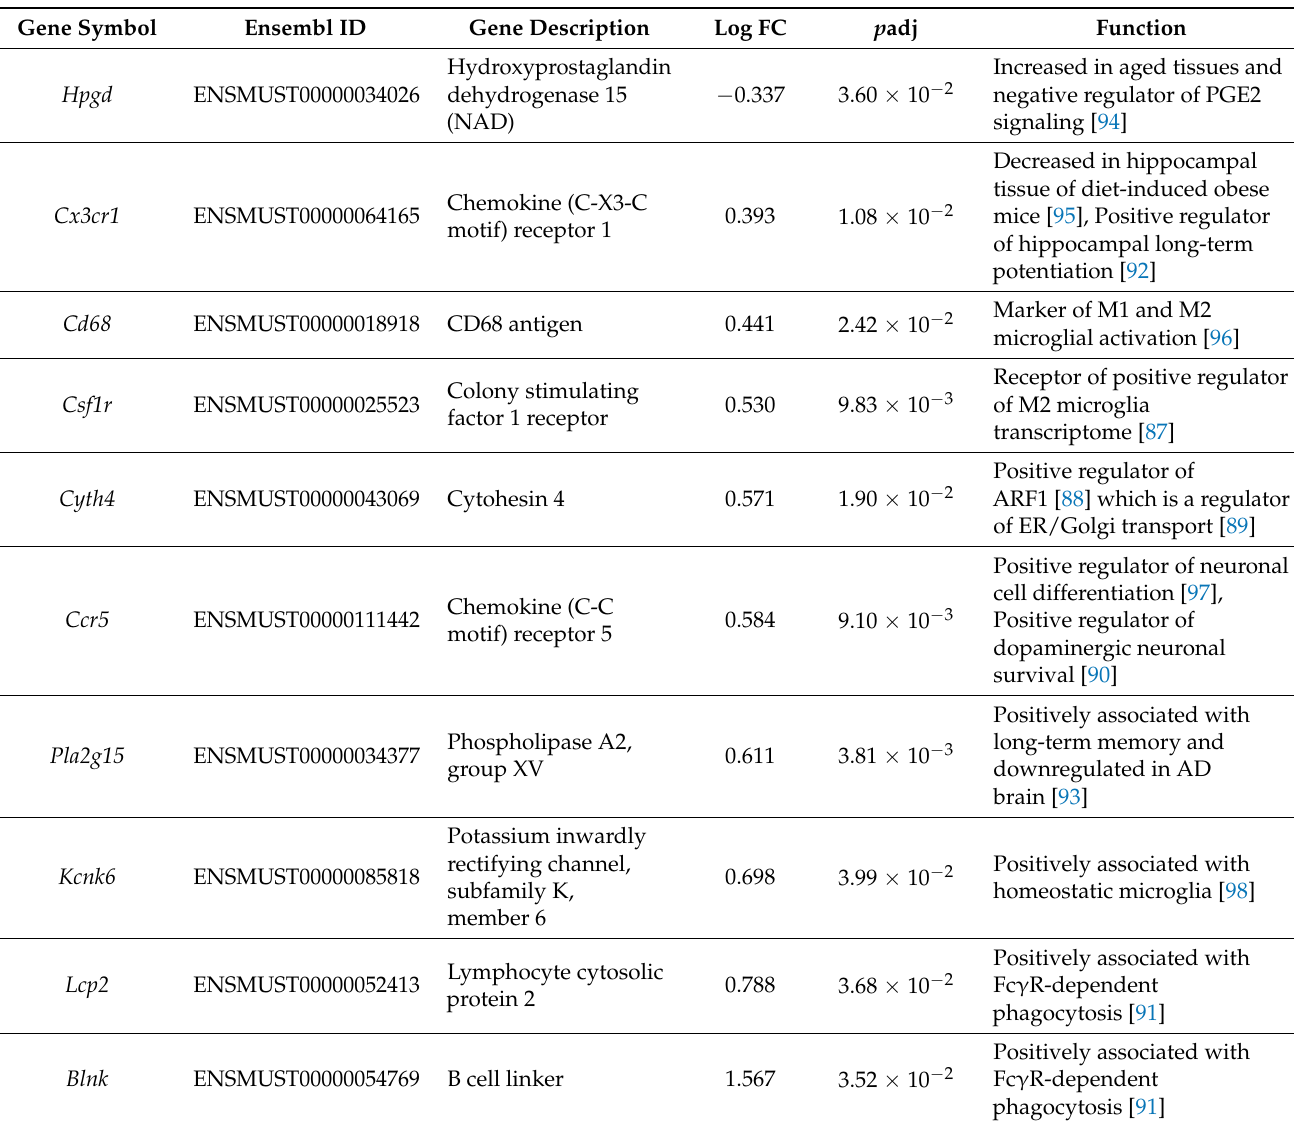
Table 4. Differentially Expressed Microglial Markers in HFD-fed AKO Compared to HFD-fed WT Mice. Transcripts with p adj ≤ 0.05 are displayed. Gene symbol, Ensembl ID, gene description, log fold change (log2), log10 adjusted p -value, and relevant known function are